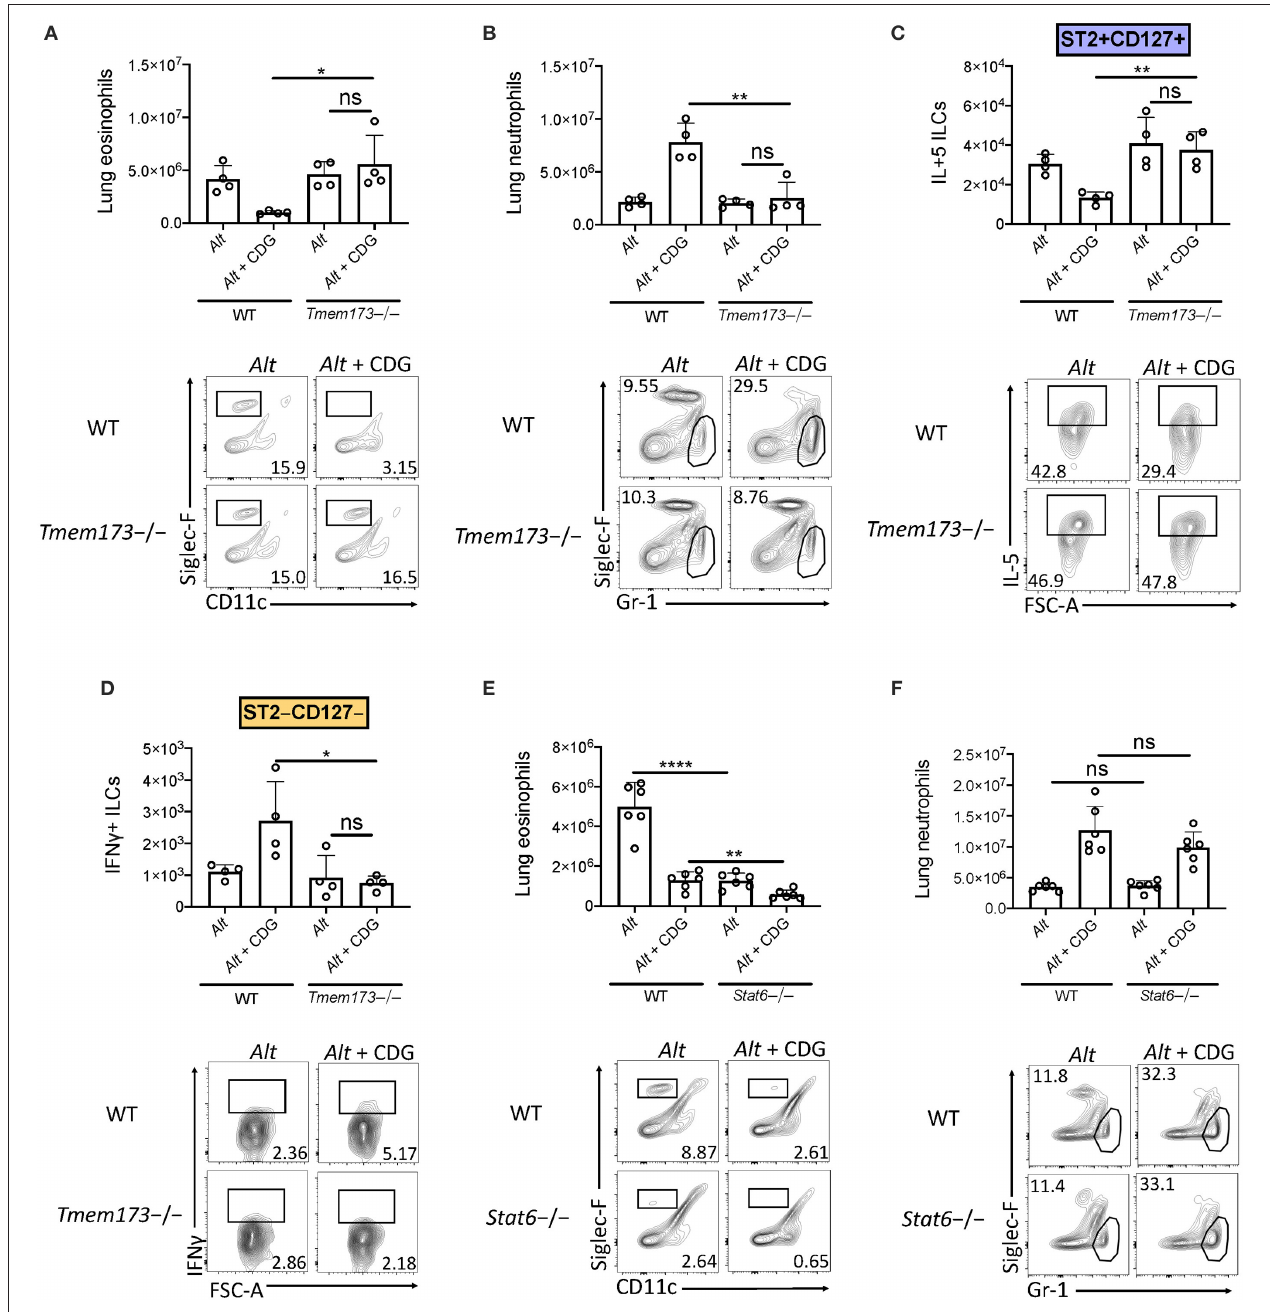
FIGURE 4 | CDG modulation of airway inflammation is STING-dependent and STAT6 independent. (A–D) Wild type and Tmem173 -/- mice were challenged using the same model as in Figure 1A . (A) Total lung eosinophils (top) and representative flow plots (bottom). (B) Total lung neutrophils (top) and representative flow plots (bottom). (C) Total lung IL-5 + ILC2s (top) and representative flow plots (bottom). (D) Total lung IFN γ + ILC1s (top) and representative plots (bottom). (E,F) Wild type and Stat6 -/- mice were challenged using the same model as in Figure 1A . (E) Total lung eosinophils (top) and representative flow plots (bottom). (F) Total lung neutrophils (top) and representative flow plots (bottom). Data shown are representative of two independent experiments with 2–3 mice per group. * P < 0.05, ** P < 0.01, **** P < 0.0001, unpaired t